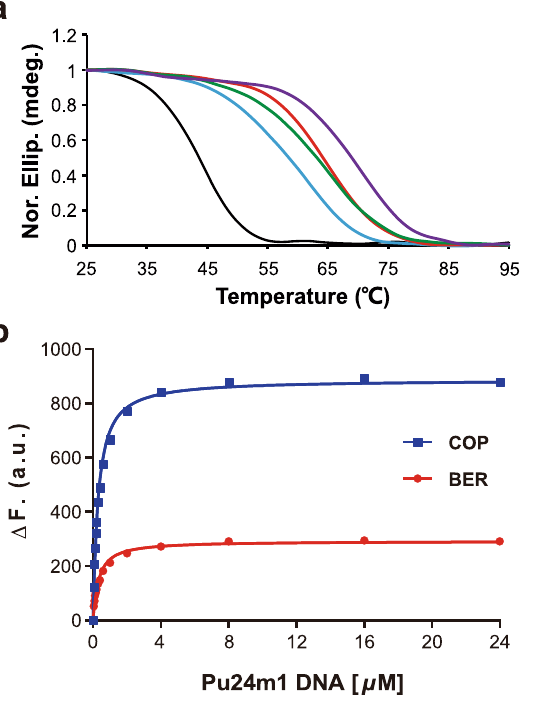
solution. c The determined Δ T m and K d values of berberine and coptisine to the Pu24m1 DNA. The melting temperature ( T m ) was obtained at the intersection betweenthe median of the fi tted baselinesand the melting curve. The dissociation constant ( K d ) was calculated by data fi tting with a 2:1 binding equation. The experiments were run in